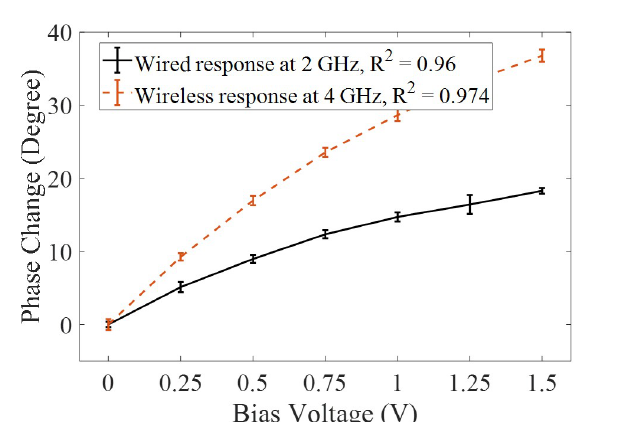
Figure 11. Measured phase change due to variable reactance (introduced with direct current (DC) biasing the varactor diode) in a wired configuration ( ∆Φ = 18.28 ◦ ) using a single frequency approach and wireless configuration ( ∆Φ = 36.78 ◦ ) using the harmonic frequency approach.